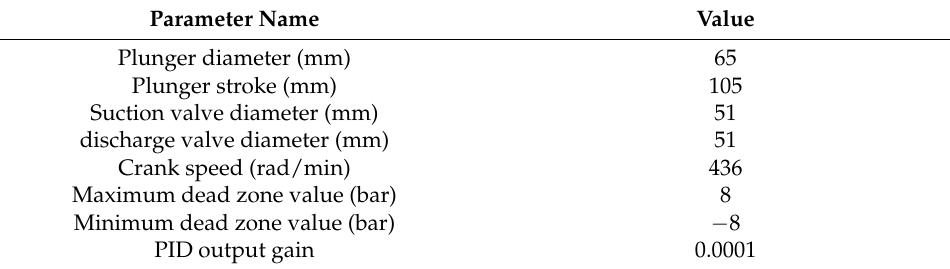
Figure 6. PID simulation model. Table 3. Main parameters of the hydraulic system.